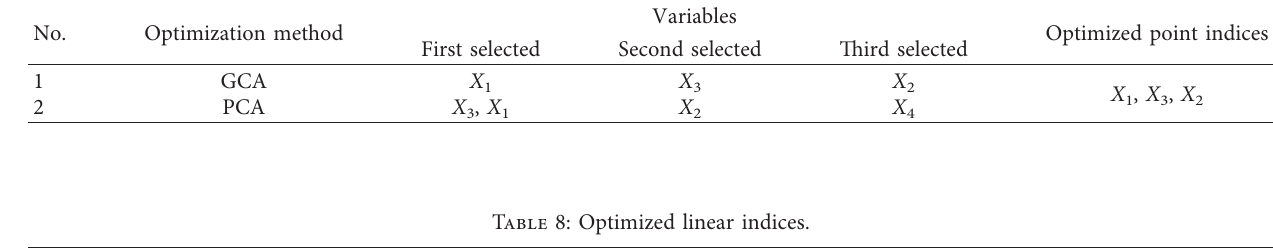
Table 7: Optimized point indices.